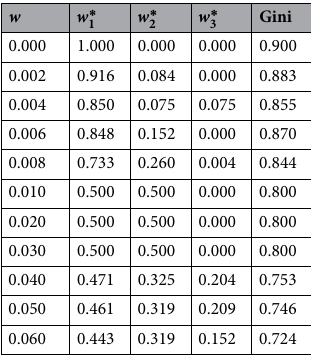
Table 2. First three prizes of the optimal ten bidder auction of Algorithm 2. Prizes of fifth rank and higher are all zero. Width of the uniform distribution around bidder bids given in column d ; Gini index of the design is in the last column.